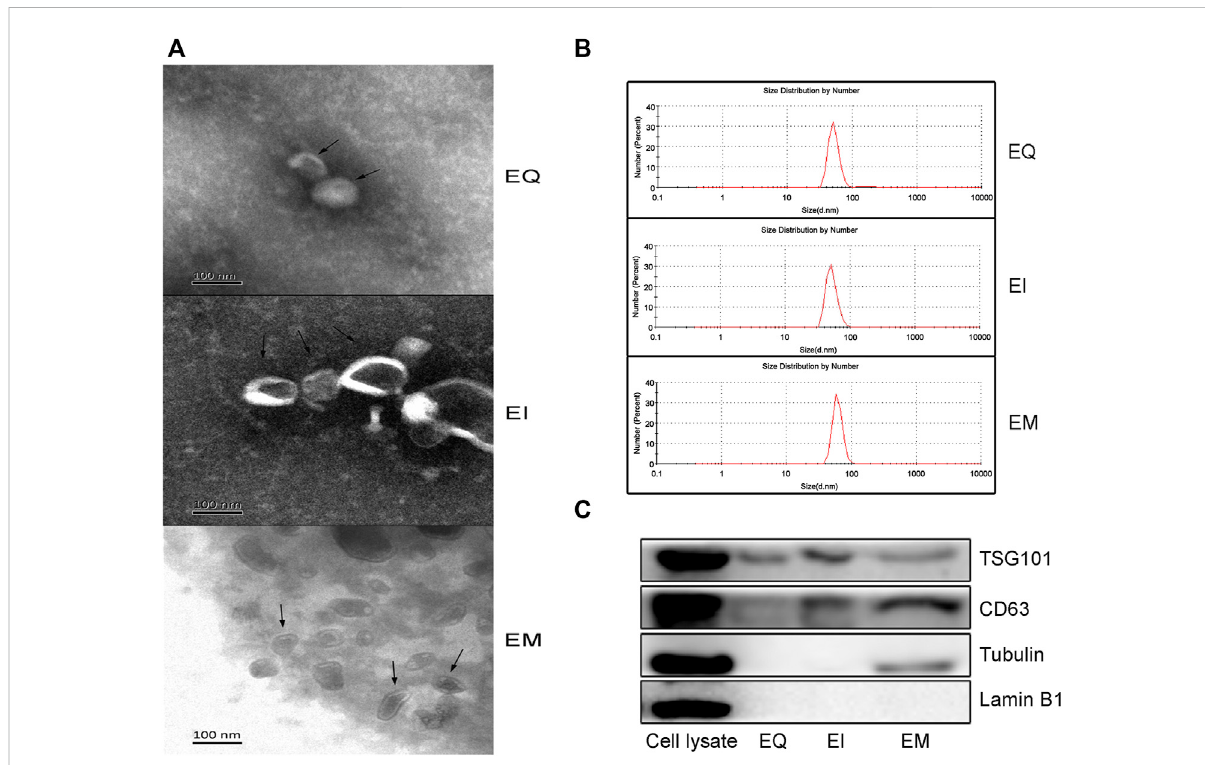
FIGURE 1 Verify EVs isolated by three EVs isolation kits, EQ, EI, and EM. 8 ml of the cell culture medium supernatant was collected from HepG2 (1.01×10 7 cells per dish), and 13.3 ml supernatant was individually applied for EVs isolation by each kit. Triple samples were analyzed for each group. (A) Transmission electron microscopy images of isolated HepG2 cell-derived EVs (arrows). (B) Nanoparticle size analyzer measurements of the size distribution ranges of isolated HepG2 cell-derived EVs. The diameter distribution of EQ, EI and EM group is respectively 51.4 – 94.9